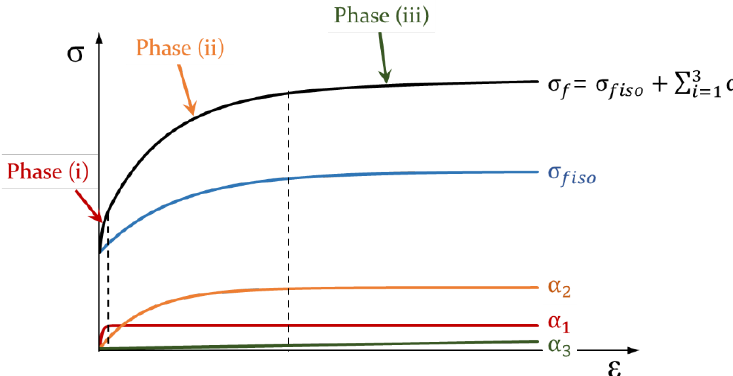
Figure 7. Features of the three decomposed back stresses in the Chaboche 86 model.